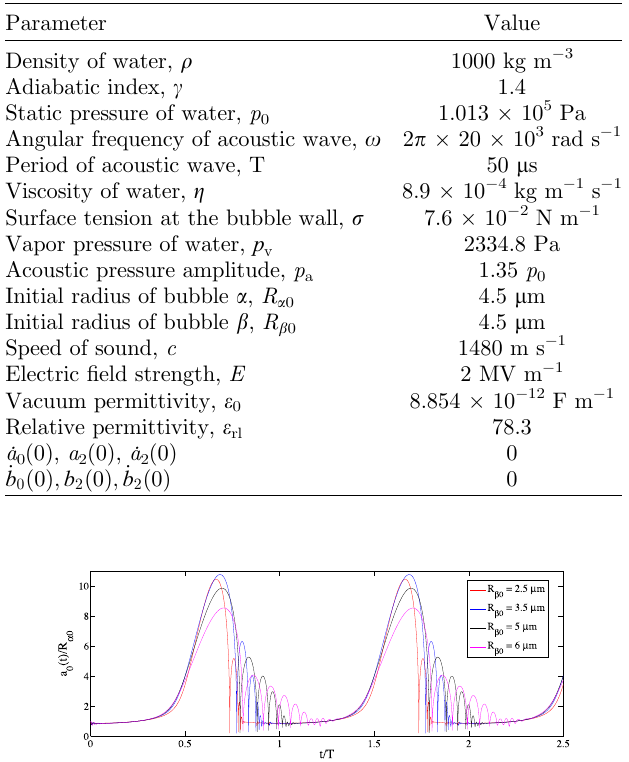
Table 1. Simulation parameters.